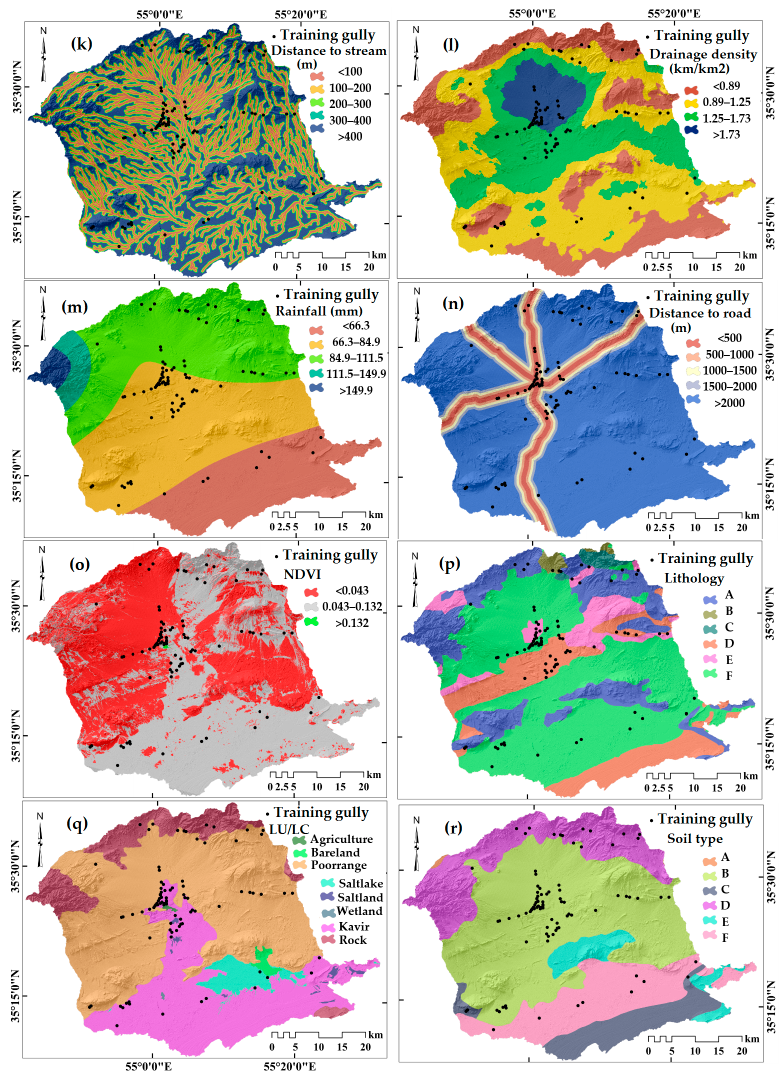
Figure 3. Gully erosion conditioning factors. ( a ) elevation, ( b ) slope, ( c ) aspect, ( d ) plan curvature, ( e ) convergence index (CI), ( f ) slope length (LS), ( g ) stream power index (SPI), ( h ) topography position index (TPI), ( i ) terrain ruggedness index (TRI), ( j ) topographical wetness index (TWI), ( k ) distance to stream, ( l ) drainage density, ( m ) rainfall, ( n ) distance to road, ( o ) NDVI (normalized difference vegetation index), ( p ) lithology, ( q ) land use/cover (LU/LC) and ( r ) soil type.